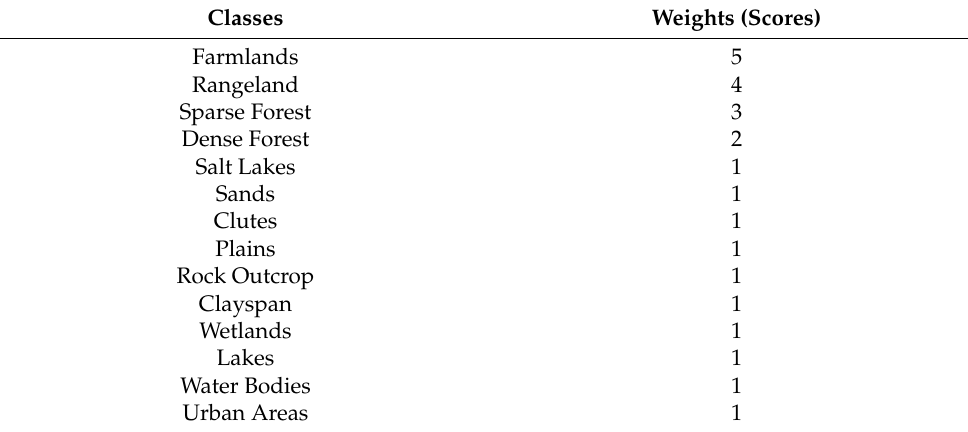
Table 5. Land use classes experts’ scores for evaluating drought vulnerability.